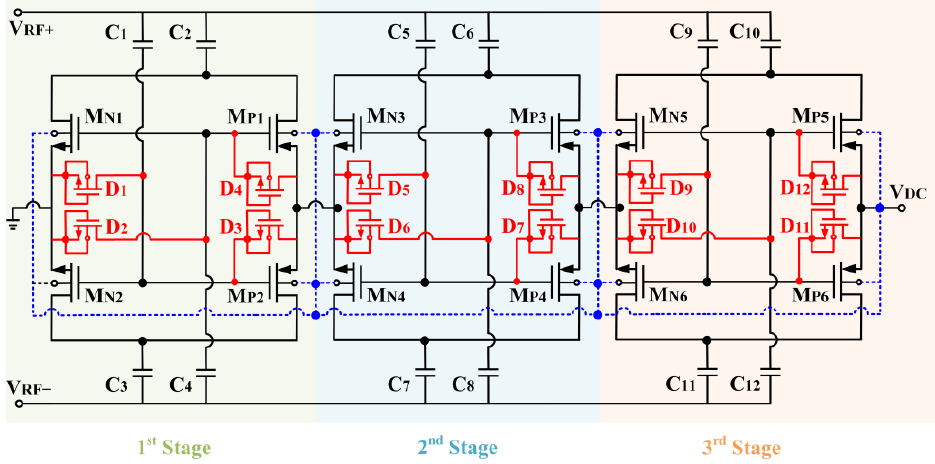
Figure 6. Schematic of the 3-stage CCDD rectifier.